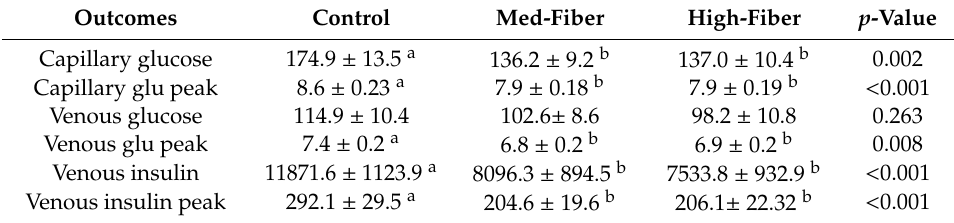
Table 4. Incremental area-under-curve (iAUC) and peak values for glucose and insulin.